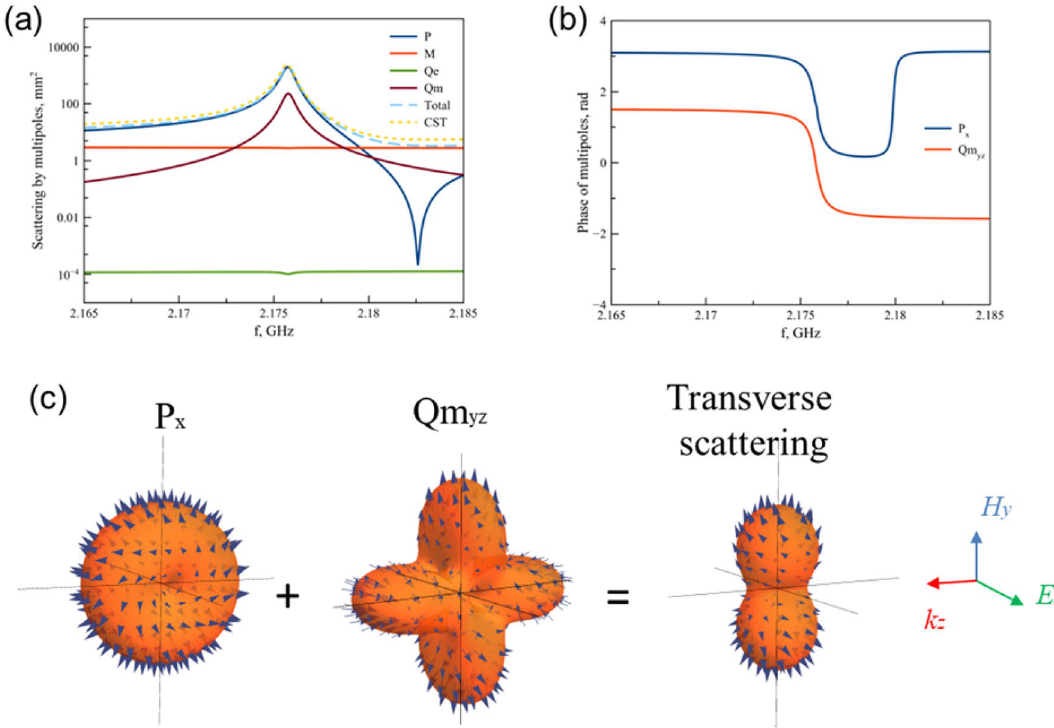
Figure 5. ( a ) Scattering cross section of multipoles on 2.175 GHz. ( b ) Phases of electric dipole and magnetic quadrupole. ( c ) Radiation pattern of excited electric dipole and magnetic quadrupole and total radiation pattern.